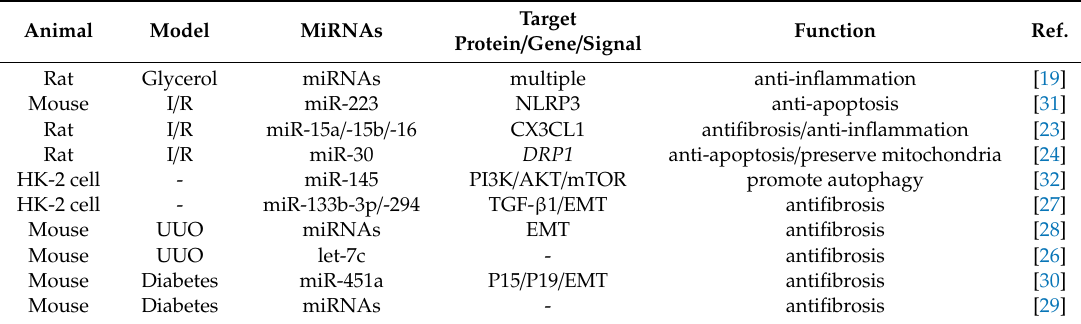
Table 1. The study of miRNA therapy from MSC-EVs in renal